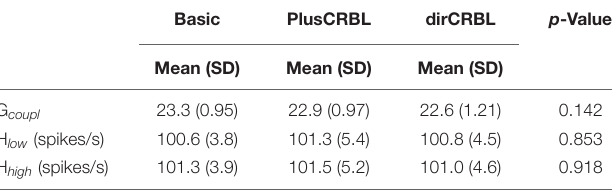
TABLE 2 | Network and model parameters.